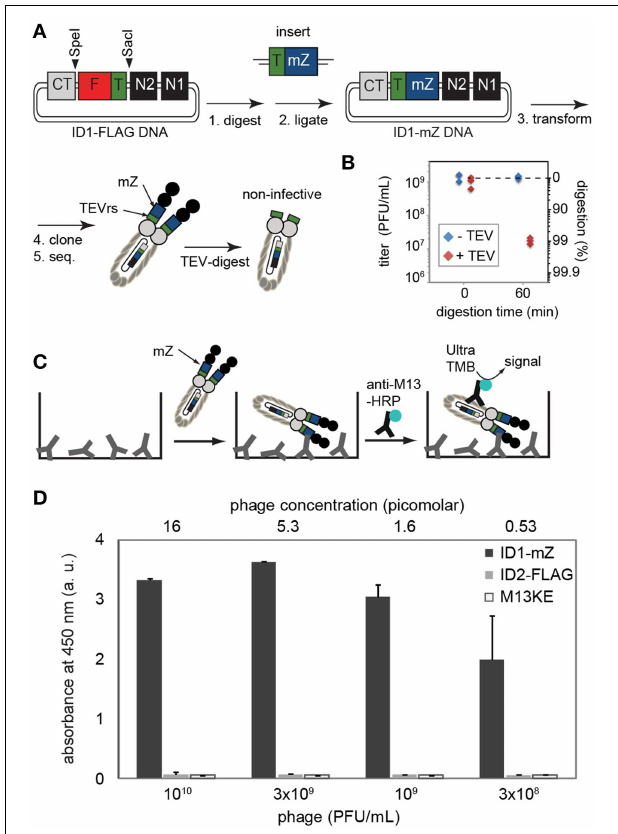
FIGURE 4 | (A) Steps toward displaying mZ protein and TEV recognition sequence. The complete sequence of the cloned construct is provided in Supplementary Materials. (B) Digestion by TEV-protease validates that at least 99% of phage contained the insert and lost infectivity in the presence of this protease. Phage do not lose infectivity in a solution that has all components (reducing agents, buffers, salts) but no TEV-protease. (C,D) The presence of inserted FLAG sequence can be validated by ELISA on wells coated by IgG antibody that binds to the mZ domain. Phage were detected using HRP-conjugated anti-M13 antibody and Ultra-TMB substrate for HRP. ID2-PhD phage that displayed FLAG sequence or original M13KE phage that displayed no sequence exhibited no binding to IgG-coated wells. Data represents average from three independent wells; error bar is one standard